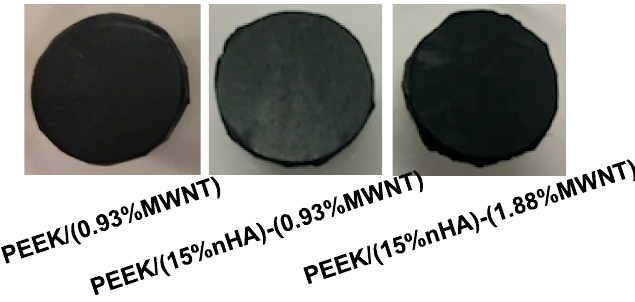
Figure 16. Photographs of Alizarin Red stained PEEK/(0.93% MWNT), PEEK/(15% nHA)-(0.93% MWNT) and PEEK/(15% nHA)-(1.88% MWNT) nanocomposites without cell exposure.